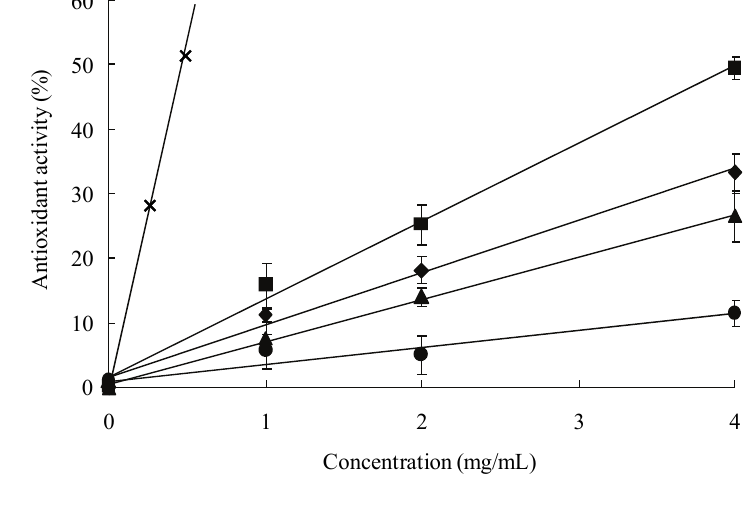
Table 1. Scavenging of DPPH radicals by different LMW